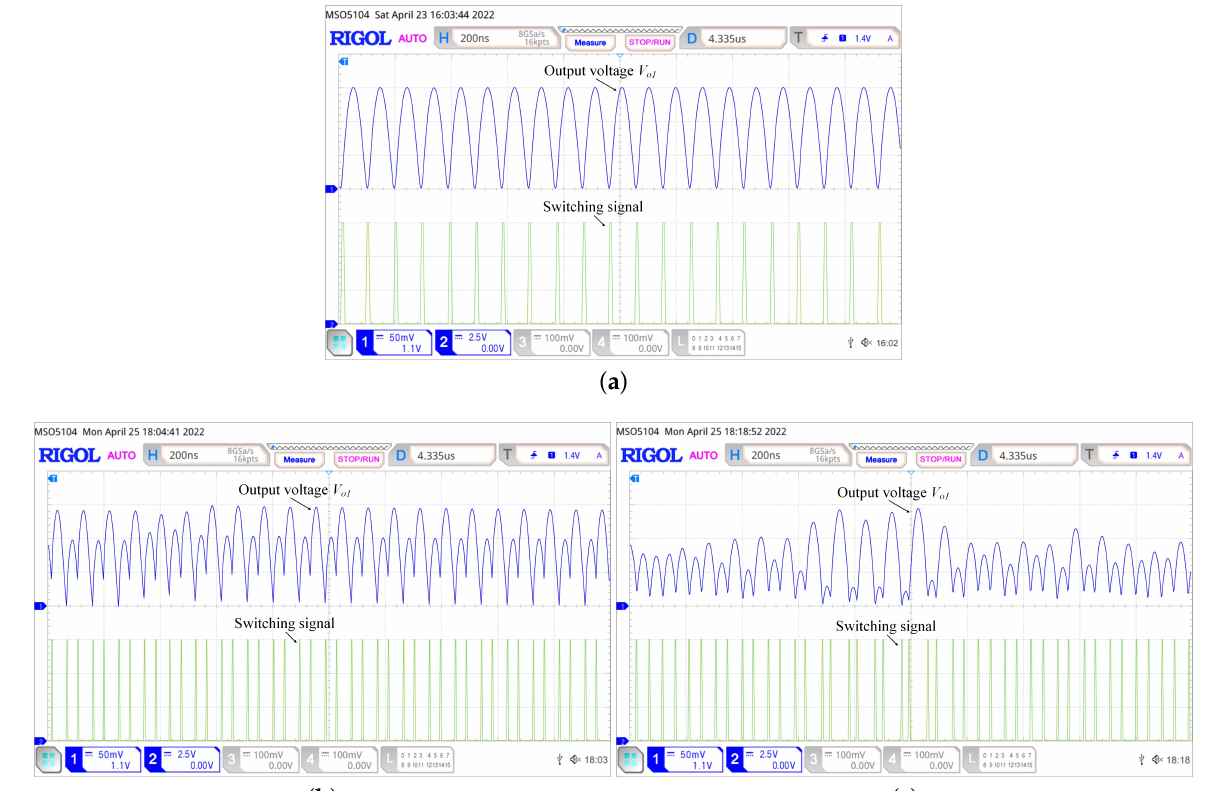
Figure 10. Experimental waveforms of the system with varying: ( a ) P CPL = 6 W. ( b ) P CPL = 24 W. ( c ) P CPL = 33.1